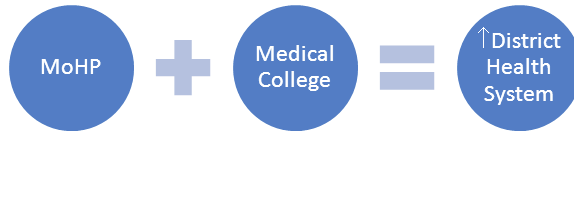
Figure 2. Strengthening of District Health Care System through Partnership with Academic